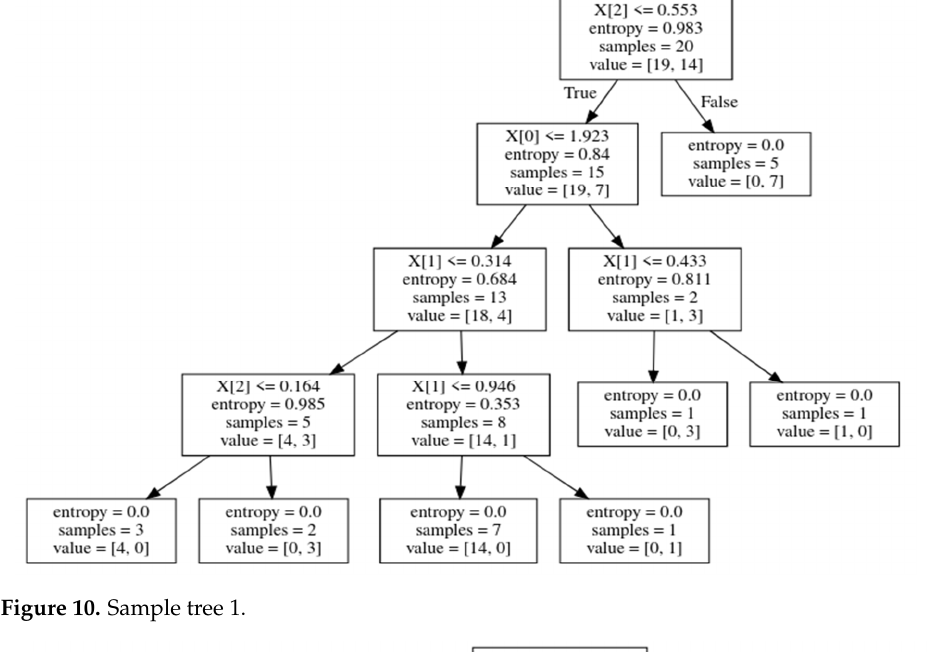
Table 12. Performance Metrics for Training Data.